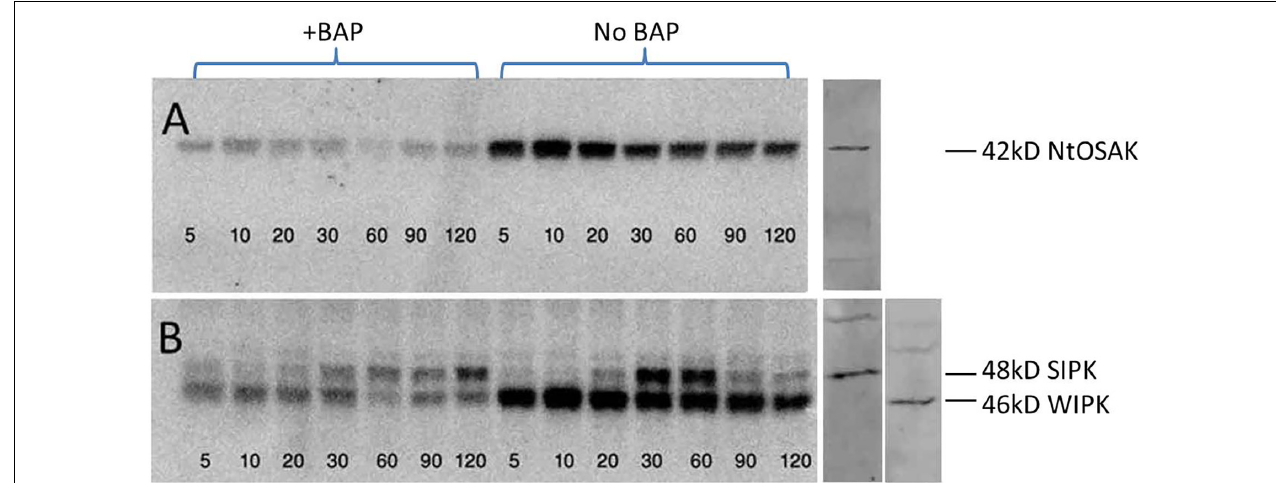
FIGURE 8 | SIPK, WIPK, and NtOSAK kinases activity during salinity stress. Tobacco BY-2 cells were grown for 5 days (at dark, 25 ◦ C). The suspension was divided into 250 ml flasks (50 ml suspension in each). After 1 h of pre-treatment incubation, NaCl was added to a final concentration of 50 mM and for the CKs treatments, 6-benzyloaminopurine (BAP), a synthetic CK, was added to final concentration of 10 µ M. Samples were collected at indicated times (min). (A) In-gel phosphorylation activity of the histone substrate OSAK, and (B) phosphorylation of MBP by SIPK and WIPK. Protein ladder 10–180 kDa (Thermo Fisher Scientific, Waltham, MA, United States) was employed for MW estimation as described in “Materials and Methods” section. Kinases were identified by western blot analysis using specific antibodies (right panel) as described in “Materials and Methods”